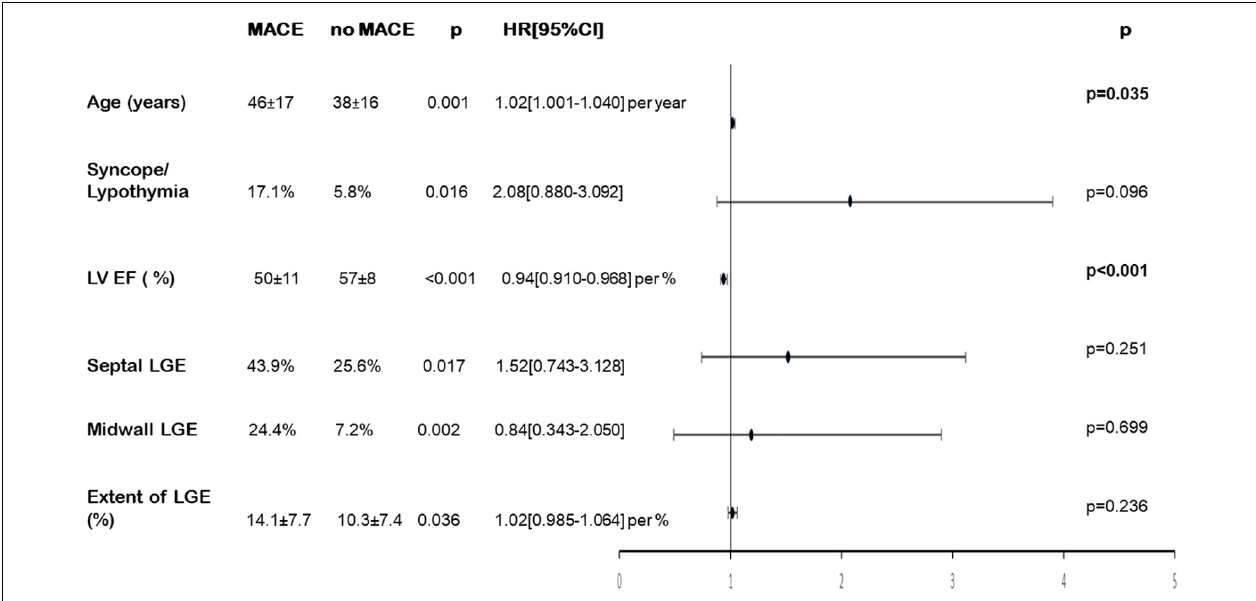
FIGURE 3 | Univariate and multivariate analysis of variables associated with MACE during follow-up. Forrest plot: Hazard ratio and 95% confidence interval for risk of MACE during follow-up. LGE, late gadolinium enhancement; LV EF, left ventricular ejection fraction; MACE, major cardiac events.